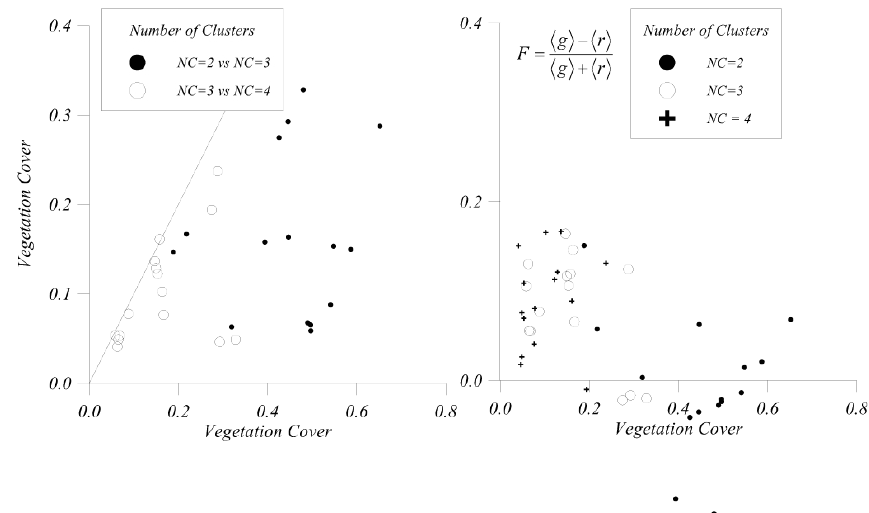
Fig. 4. Vegetation cover evaluated by image analysis with different number of clusters NC (see legend) and vegetation greenness F